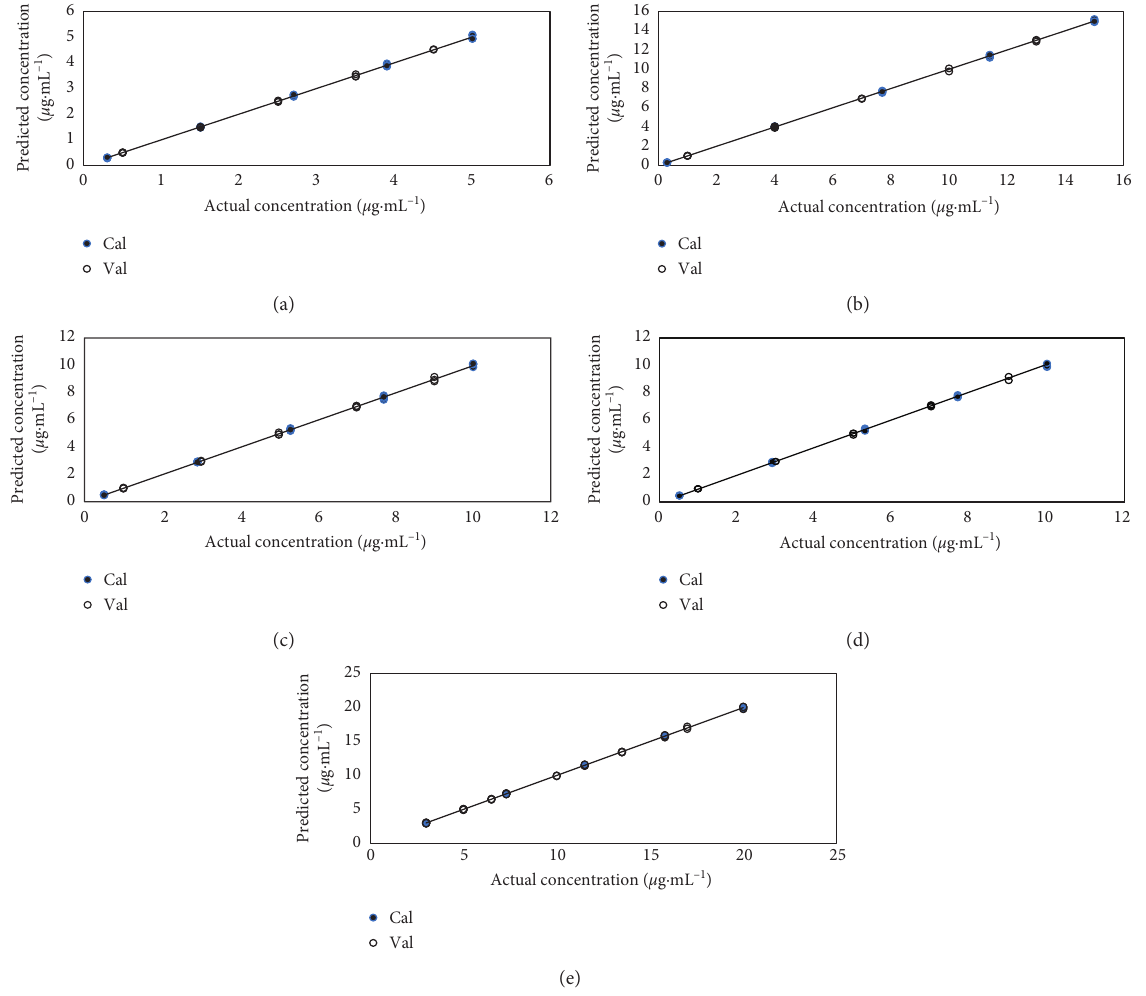
Figure 2: Scatter plot of actual analytes concentration versus the MCR-ALS-predicted concentrations of (a) CHZ, (b) CRZ, (c) HAL, (d) IMP, and (e) PTN. Table 2: Figures of merit of the MCR-ALS regression model for the calibration set of HAL, IMP, CHZ, CRZ, and PTN. Parameters Calibration range ( μ g · mL − 1 )